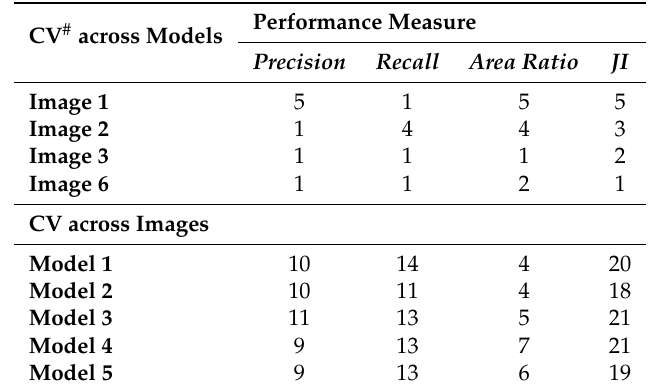
Table 4. Results